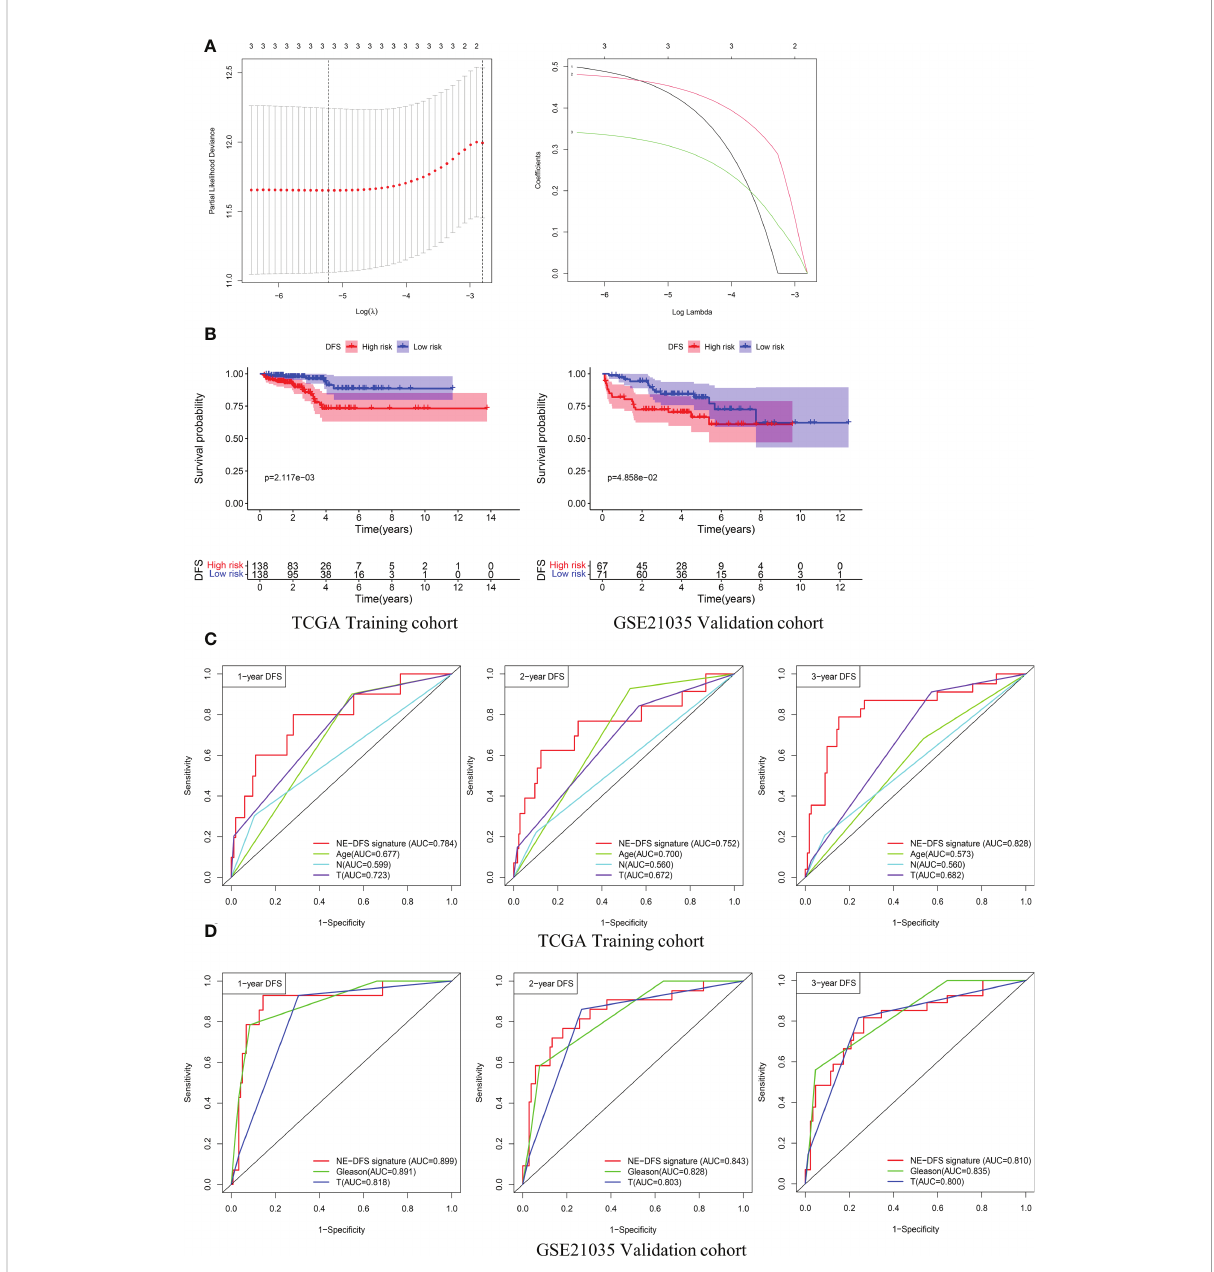
FIGURE 9 A 2-gene prognosis model for DFS (NE-DFS signature) in the TCGA PanCancer training cohort and GSE21035 validation cohort in PCa. (A) Three genes signi fi cantly correlated with DFS were identi fi ed through LASSO regression analysis and ten-fold cross-validations for screening of the optimal parameter lambda (B) Kaplan – Meier curves displayed that high-risk group exhibited worse DFS than low risk group in TCGA PanCancer training group (n=276) and GSE21035 group (n=138). (C, D) Receiver operating characteristic (ROC) curves of the NE-DFS signature had better Predictive effectiveness than age, tumor stage and lymph node status to evaluate the predictability of DFS at 1-, 2- and 3- year in the TCGA PanCancer training cohort, similar phenomena were observed in the GSE21035 validation